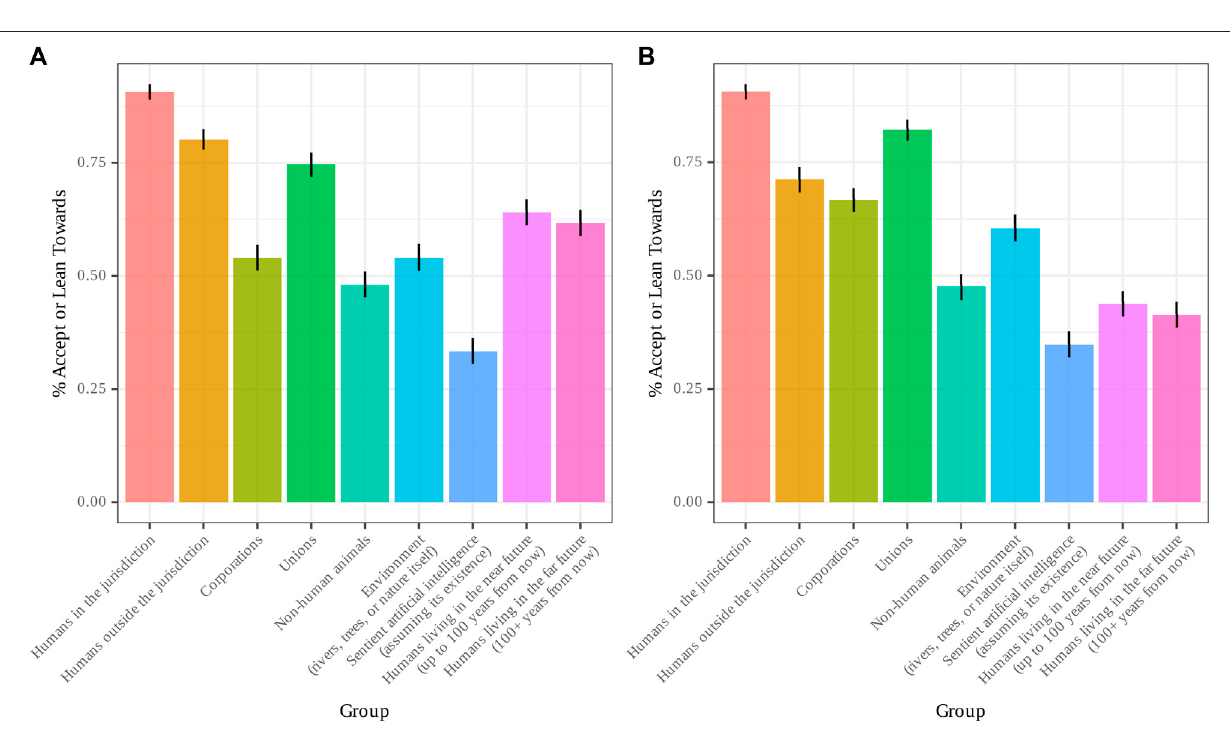
Frontiers in Robotics and AI |